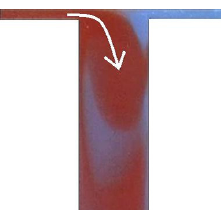
Fig. 2 Observed layered flow pattern in T-shaped channel.